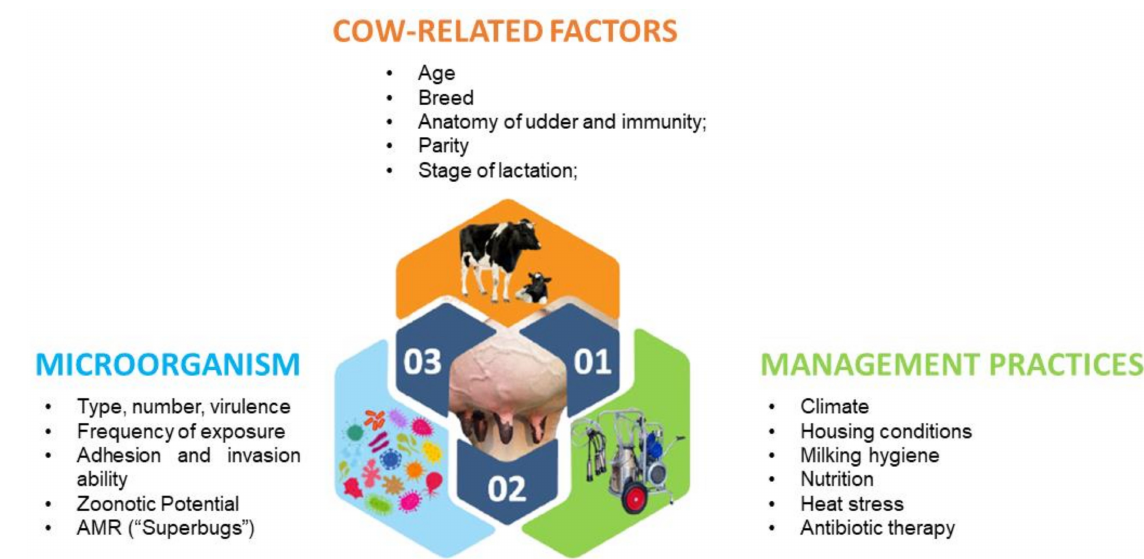
Figure 5. Host, microorganism and environmental factors with the potential of inducing mastitis in dairy